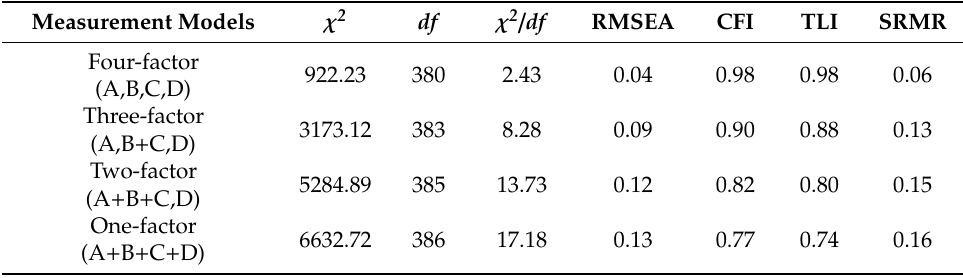
Table 1. Results of confirmatory factor analysis of the measurement